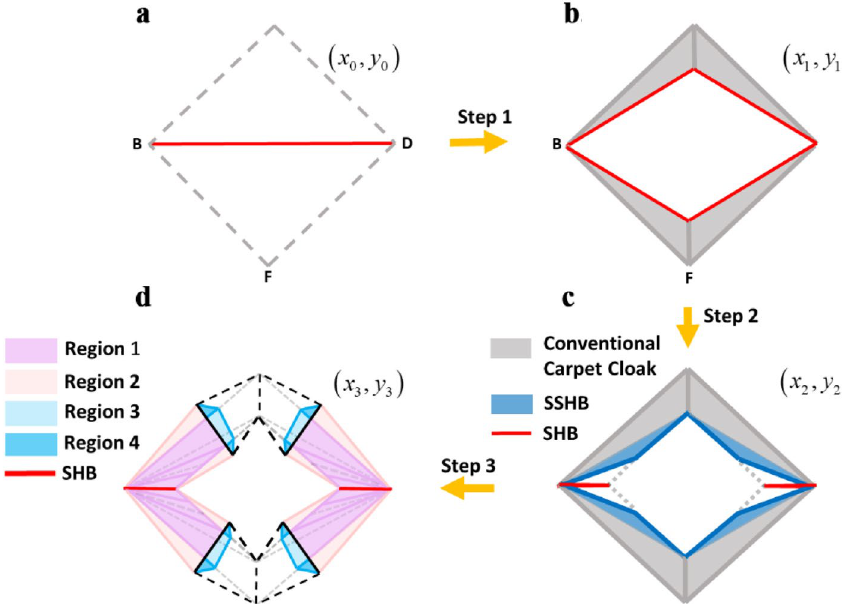
Figure 6. Scheme illustration of the free space fenestrated cloak ( a – d ) The three design steps. The unidirectional cloak is achieved by transforming the diamond space specified by grey dashed line to the space